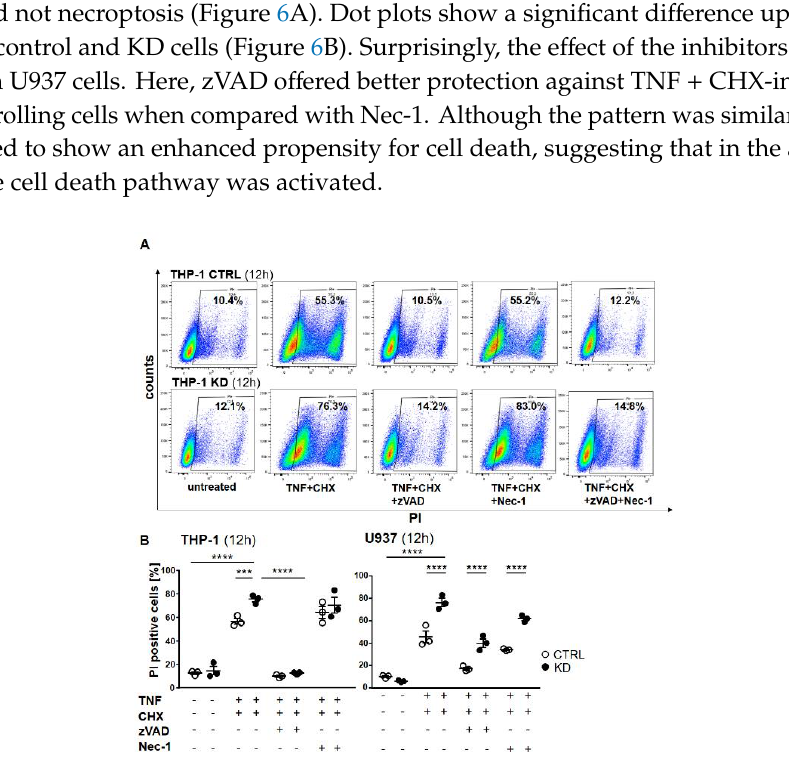
Figure 5. Depletion of YB-1 led to effector caspase activation. (A,B) Flow cytometry analyses of caspase-3/7 activation in THP-1 ( A ) and U937 cells ( B ). Cells were treated with or without TNF (20 ng/mL) alone or together with cycloheximide (10 ng/mL) for 4 h. Cells were harvested and stained for